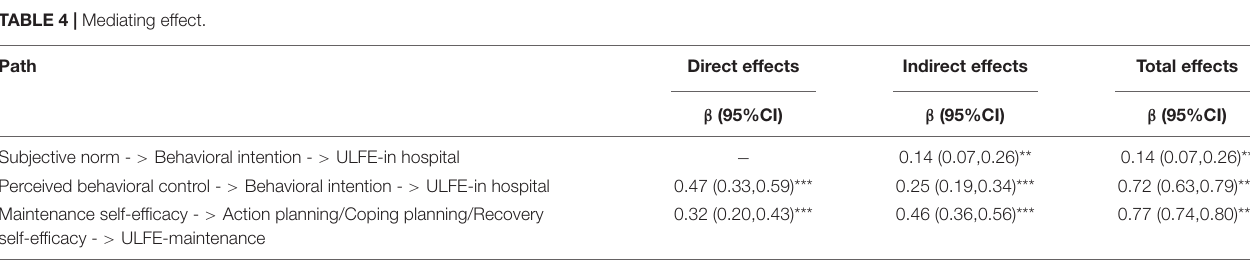
FIGURE 1 | Standardized path coefficients for the structural equation model explaining and predicting upper limb functional exercise behavior based on the HAPA-TPB integrated model. ∗ P < 0.05; ∗∗∗ P < 0.001. TABLE 4 | Mediating